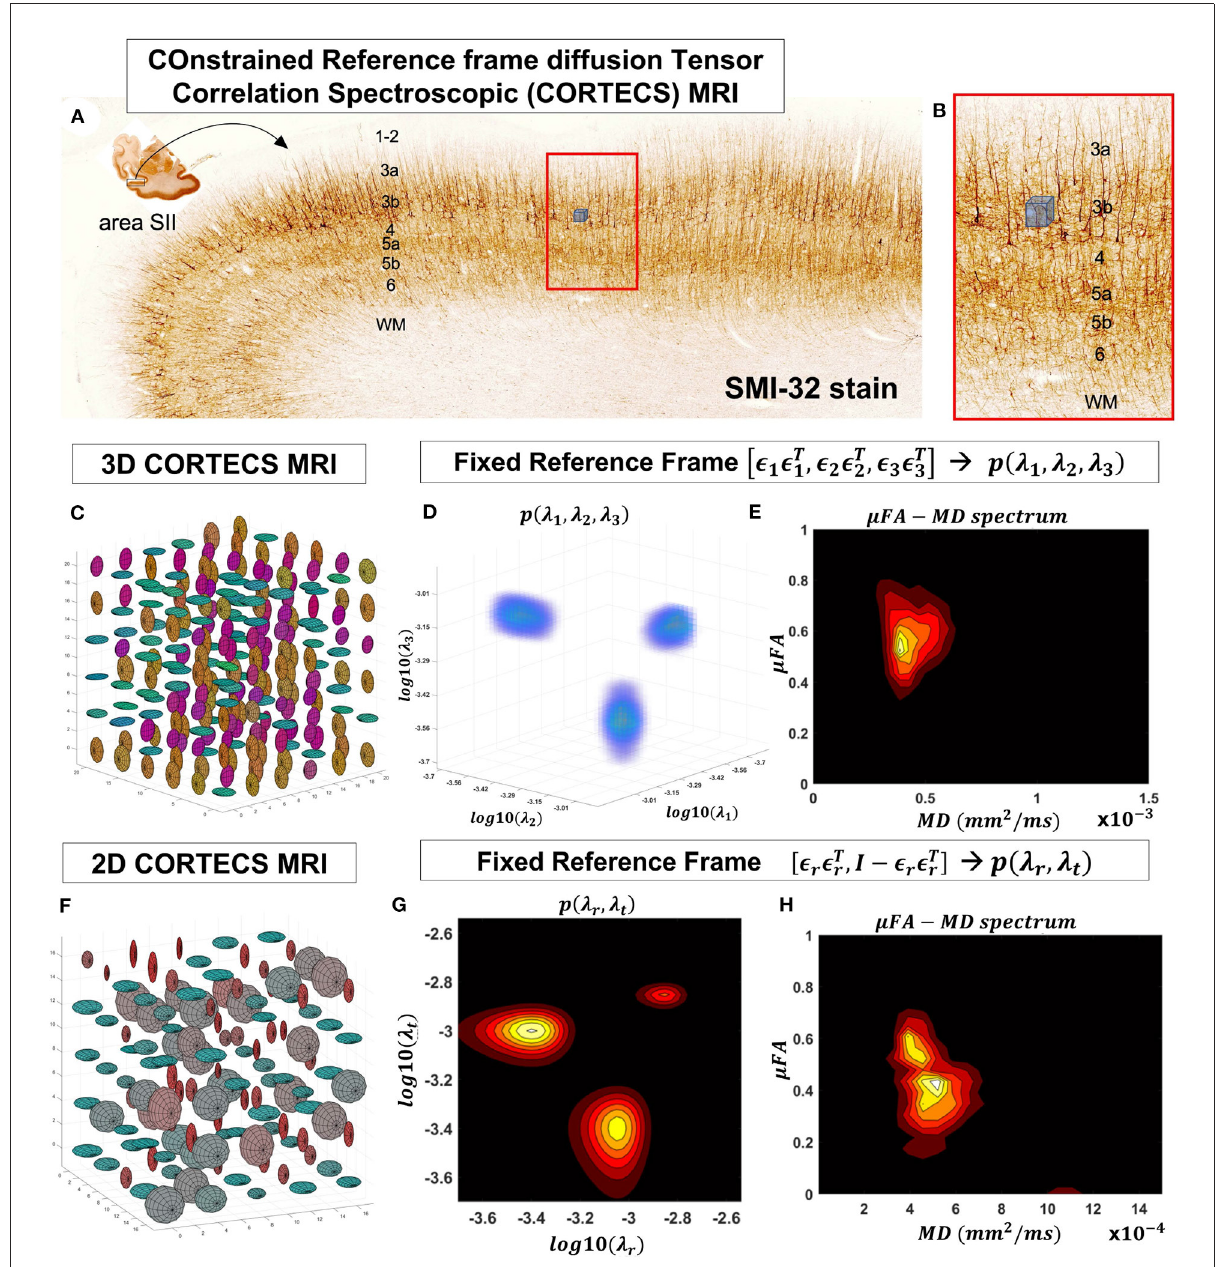
FIGURE2 At a mesoscopic length scale cortical cyto- and myeloarchitecture is organized preferentially along the axes of an orthogonal frame of reference (A) . If the dMRI spatial resolution is sufficiently small (Figure 1) we can measure DTDs efficiently using the constraints of the CORTECS MRI framework (B) . If we constrain all microscopic diffusion tensors to have the same principal axes of diffusion (C) we can quantify the DTD as the 3D correlation spectrum of the corresponding principal diffusivities (D) . If the microarchitecture varies along a single radial orientation, we can further constrain the DTD to contain only axisymmetric tensors (F) and quantify the 2D correlation spectrum of the corresponding radial and tangential diffusivities (G) . We can also quantify the shape-size (i.e., microscopic FA-MD) correlation spectra of microscopic tensors from the 3D (E) or 2D (H) constrained reference frame DTDs